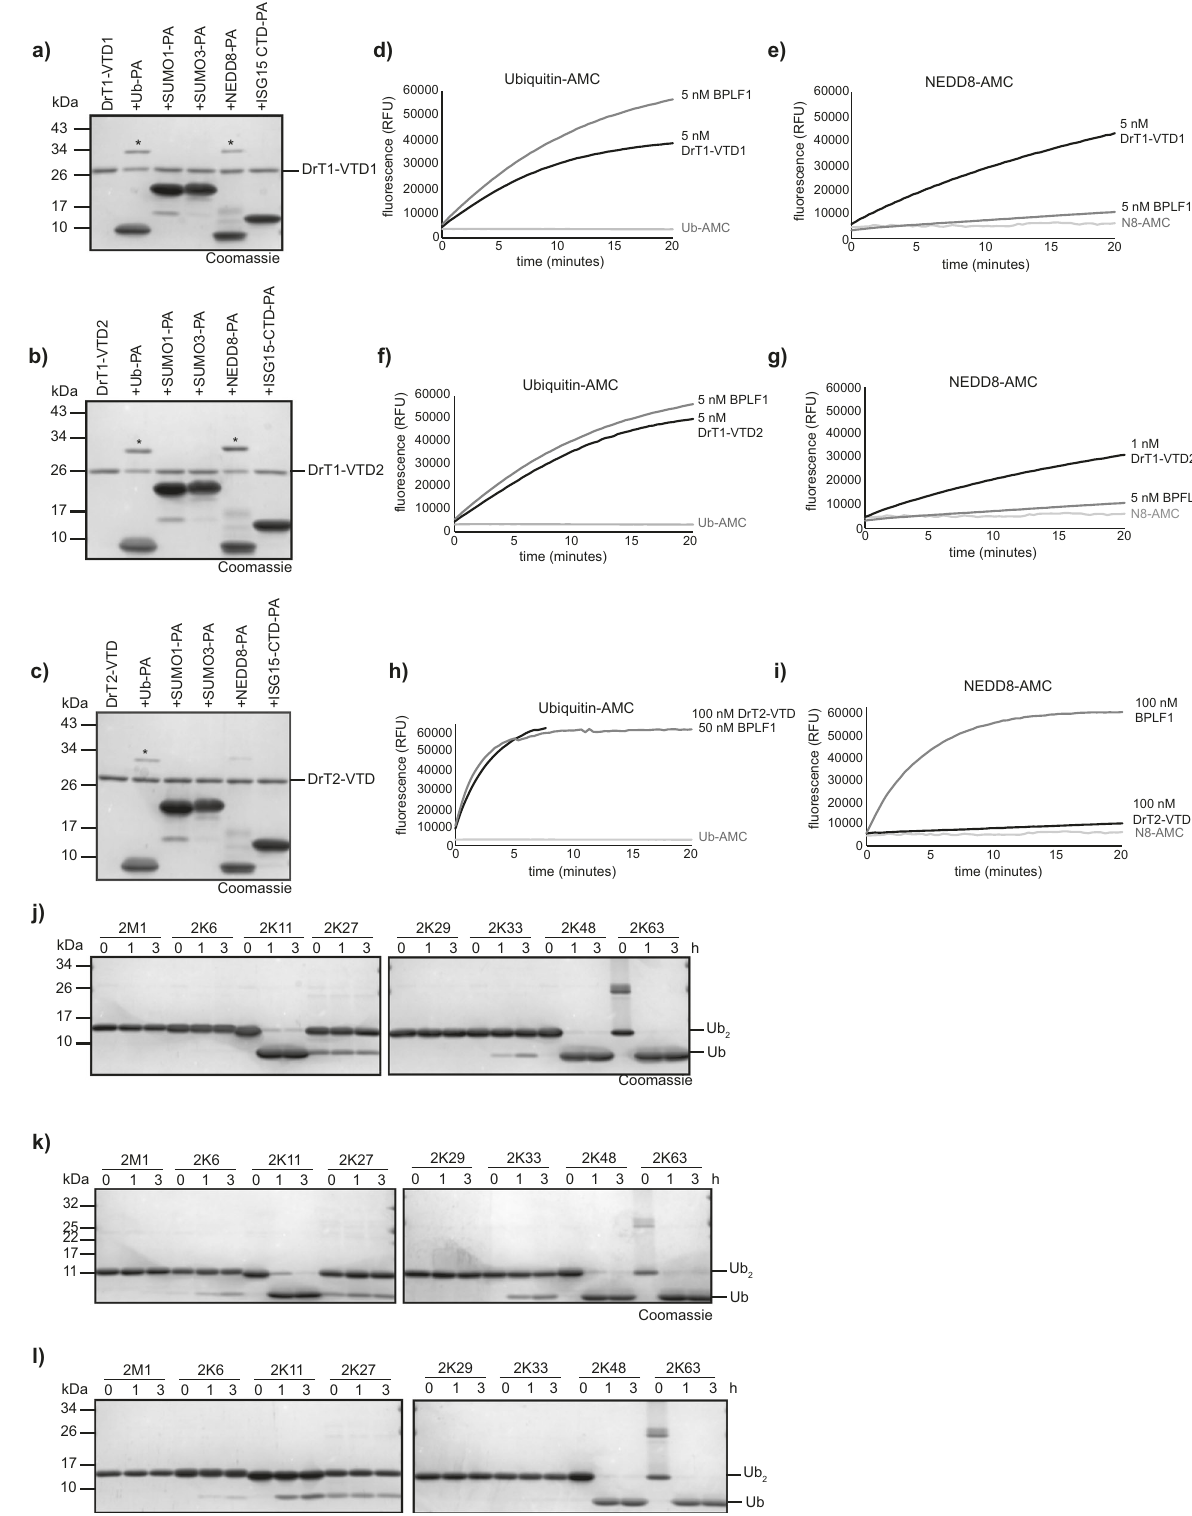
h , i Activity of 100nM DrT2-VTD or 50nM BPLF1 against Ubiquitin-AMC ( h ) and of 100nM DrT2-VTD or BPLF1 against NEDD8-AMC ( i ). The RFU values are the means of triplicates. j – l Linkagespeci fi city analysisof DrT-VTDs. A panel of homotypic di- ubiquitin chains was incubated with DrT1-VTD1 ( j ), DrT1-VTD2 ( k ) or DrT2-VTD ( l ) for the indicated time points. Source data are provided as a Source Data fi